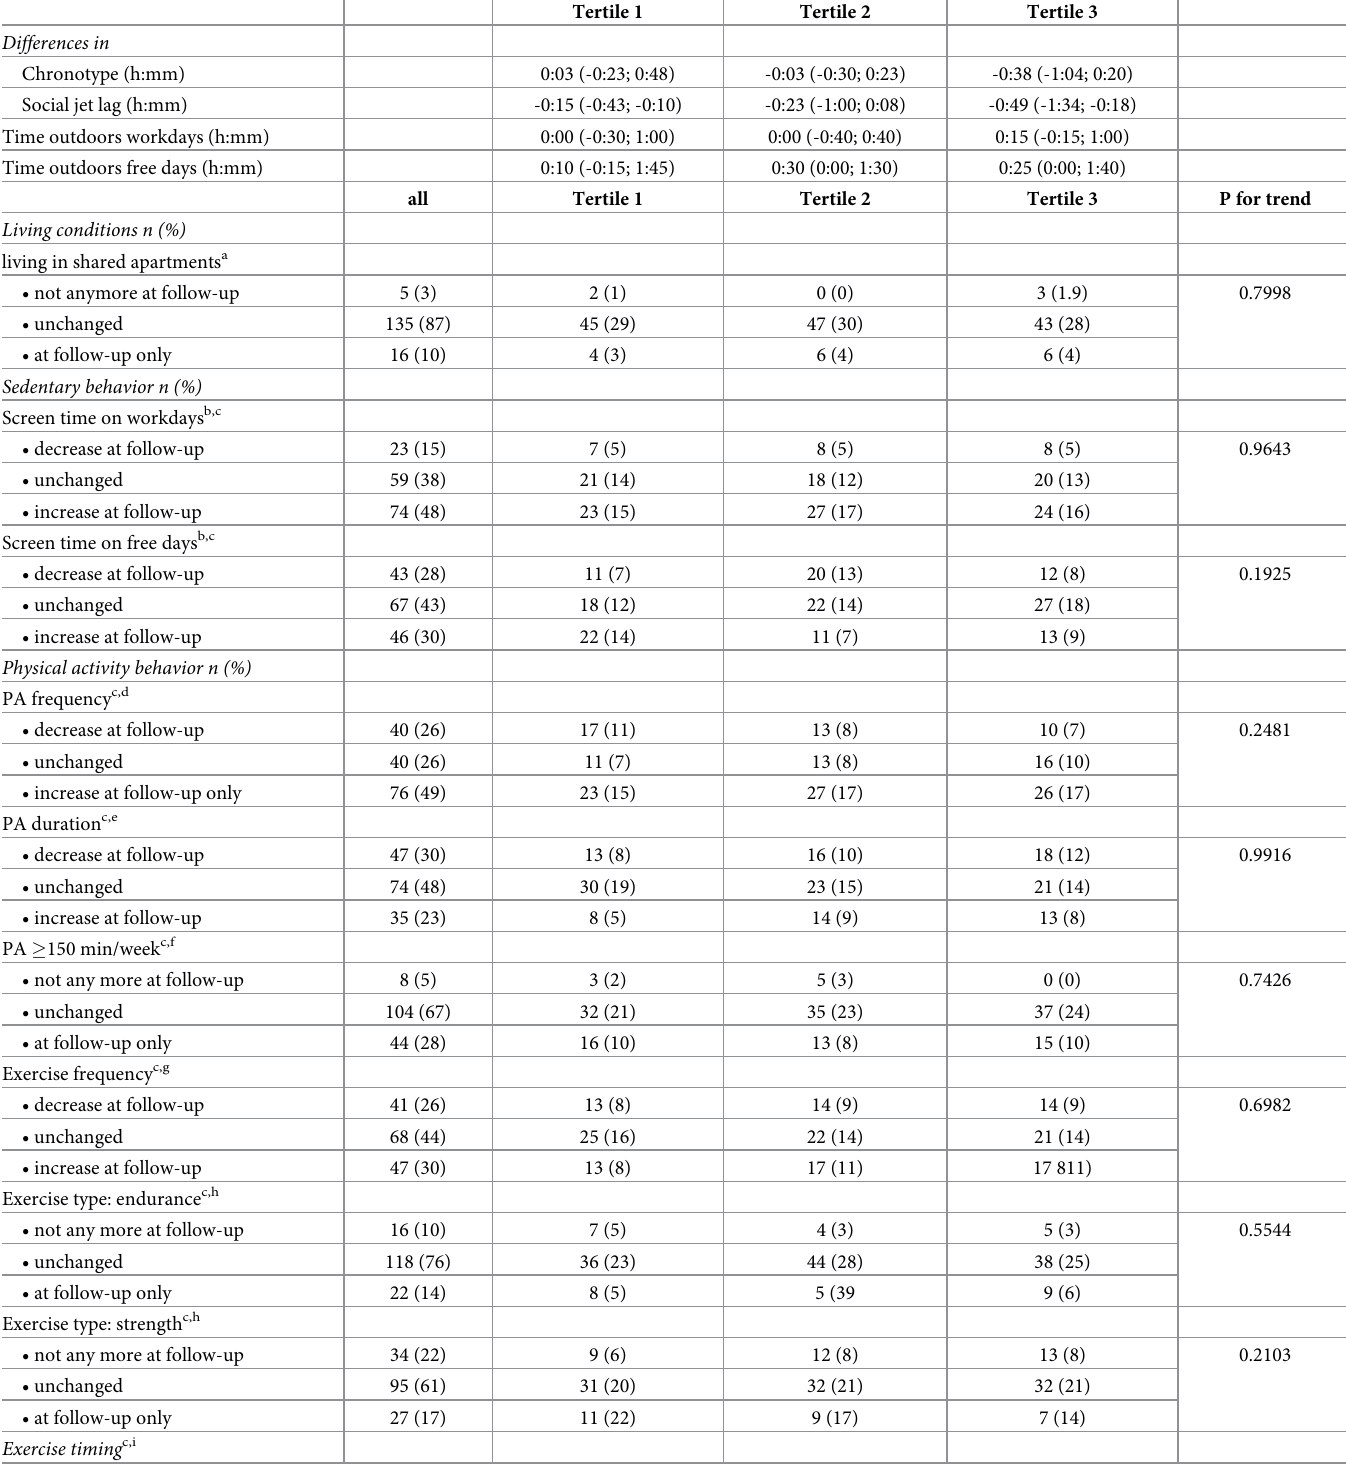
Table 4. Changes in chronotype, social jetlag and life factors from baseline (Oct 2019-Jan 2020) to follow-up (June 2021) by tertiles of chronotype at baseline (n =